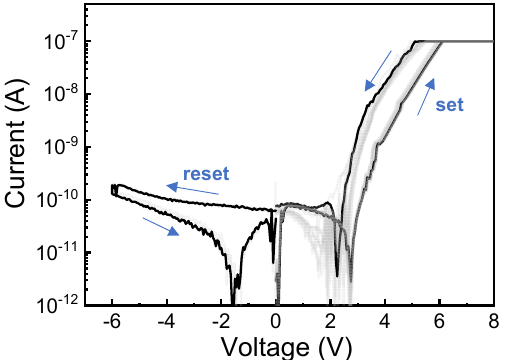
Figure 2. I–V characteristics with self-rectification of Pt/HfO 2 /TaO x /TiN device.